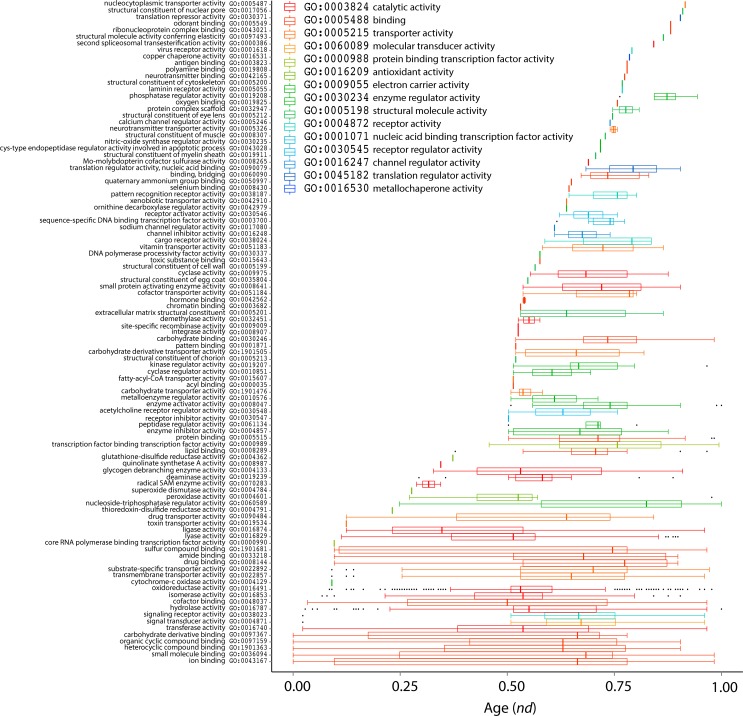
Boxplot displaying the distribution of level 2 GO terms with respect to age (nd) in GOTMF terms of 249 organisms.